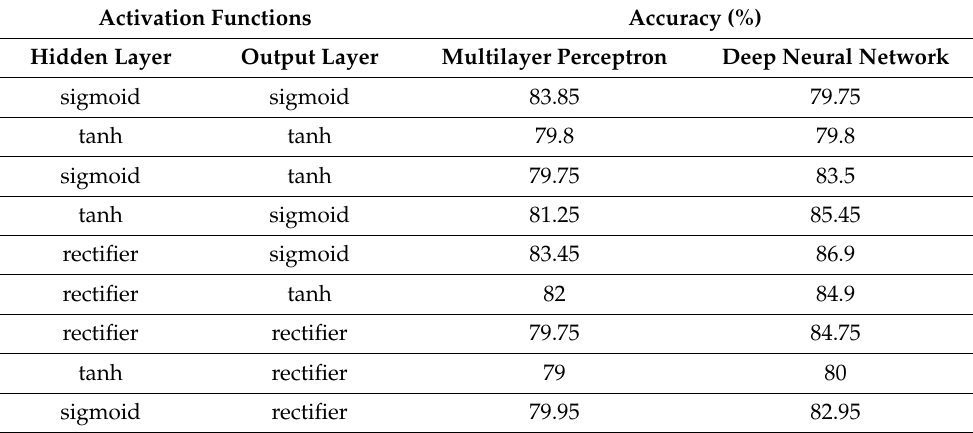
Table 6. Activation and output function